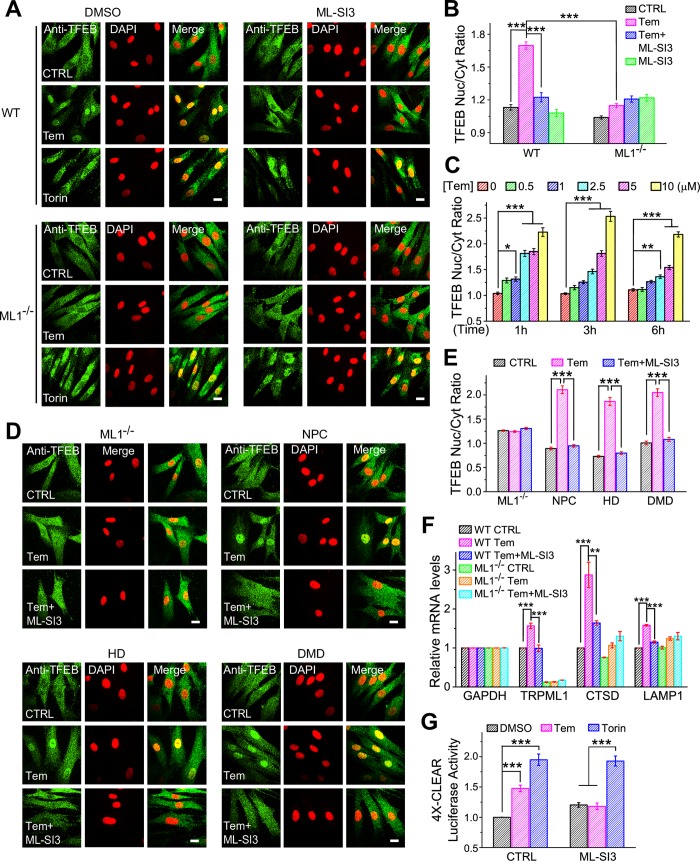
Tem activates the endogenous TRPML1-TFEB pathway.(A) Tem (10 μM, 9 h) induced TFEB (green) nuclear translocation in WT but not ML1−/− fibroblasts. TFEB nuclear translocation was inhibited by coapplication of ML-SI3 (10 μM). Nuclei were labelled with DAPI (red, pseudo-color). Scale bar = 10 μm. (B) Summary of Tem effects on TFEB nuclear translocation in WT and ML1−/− human fibroblasts. (C) Dose-dependent and time-dependent effects of Tem on TFEB translocation. (D) The effects of Tem (10 μM, 6 h) on cells derived from human disease tissues, e.g., ML1−/−, NPC, HD, and DMD. (E) Quantification of Tem effects shown in (D). Data shown in B, C, and E were obtained from more than 40 cells from at least 3 independent experiments. (F) The effects of Tem (10 μM, 16 h) on mRNA expression levels of TRPML1, CTSD, and LAMP1 (n = 3–5 independent experiments). (G) The effects of Tem (10 μM, 16 h) on TFEB activity, measured using a 4X-CLEAR luciferase reporter (n = 4 independent experiments); Torin-1 (1 μM, 16 h) was used as a positive control. Data shown in B, C,and E–G are presented as mean ± SEM, and the individual data can be found in S1 Data. *P < 0.05, **P < 0.01, ***P < 0.001, one-way ANOVA. CTRL, control; CTSD, cathepsin D; Cyt, cytoplasm; DMD, Duchenne Muscular Dystrophy; GAPDH, Glyceraldehyde 3-phosphate dehydrogenase; HD, Huntington disease; LAMP1, lysosome-associated membrane protein 1; ML1−/−, Mucolipidosis IV; ML-SI3, TRPML1 synthetic inhibitor 3; NPC, Niemann-Pick type C; Nuc, nuclear; Tem, temsirolimus; TFEB, transcription factor EB; TRPML1, transient receptor potential channel mucolipin 1; WT, wild type; 4X-CLEAR, four CLEAR elements (GTCACGTGAC) in tandem derived from LAMP1 promoter + HTK.